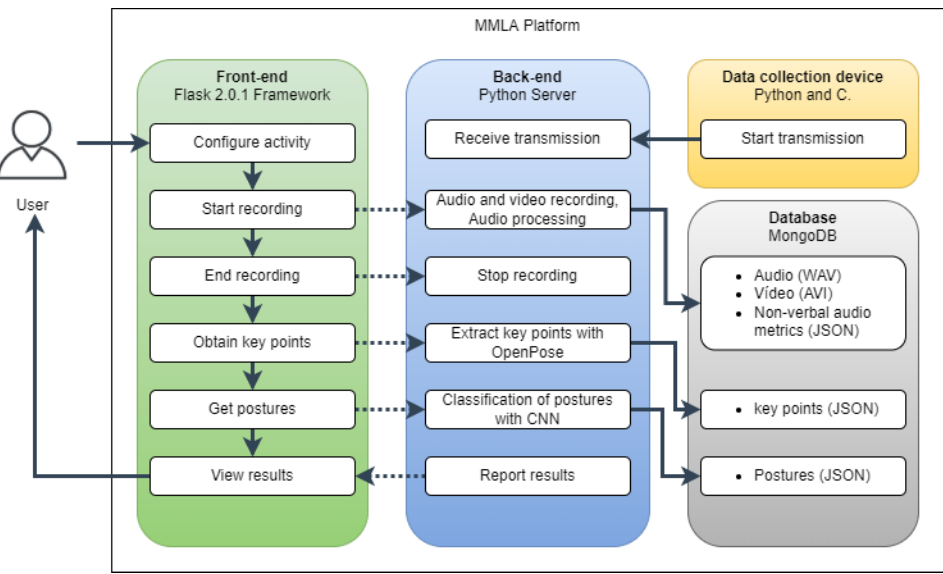
Figure 2. Data flow in the web application of the developed